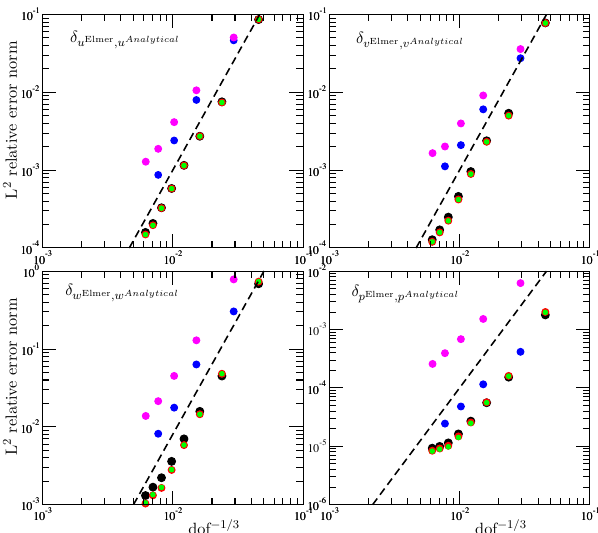
Fig. 2. Evolution of the L 2 relative error norm between two consecutive solutions of the Stokes system, δ u p ,u p +1 , as a function of the non-linear iteration, for a switch criterion from the Picard to the Newton scheme of 10 − 6 (Picard only, black curve), red 10 − 2 , green 10 − 1 , blue 1 and magenta 2 (Newton only), for the ISMIP HOM experiment A005 with initial conditions (circle) assuming zero velocity and pressure and (triangle) estimated from the SIA solution. The colour of the dot-dashed lines indicates the value of the switch criterion of the corresponding colour curve.